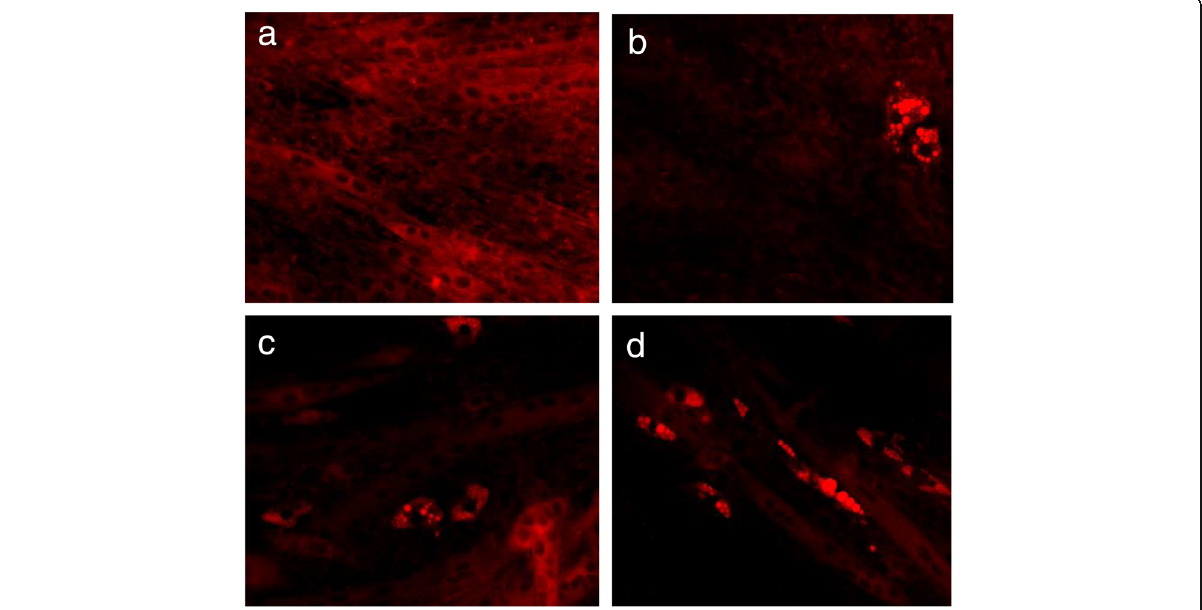
Fig. 1 Differentiation of Myf5 lineage precursor cells upon stimulants. Lipid droplets formation upon adipogenesis was stain by Nile Red solution. Treatment of myoblasts with adipogenesis stimulants facilitated myocytes and adipocytes co-differentiation in the presence of ( b ) 1 μ M ROSI, ( c ) 100 μ g/ml DBB, and ( d ) 200 μ g/ml DBB. ( a ) 0.5% DMSO (vehicle) showed a complete process of myogenesis without ROSI and DBB